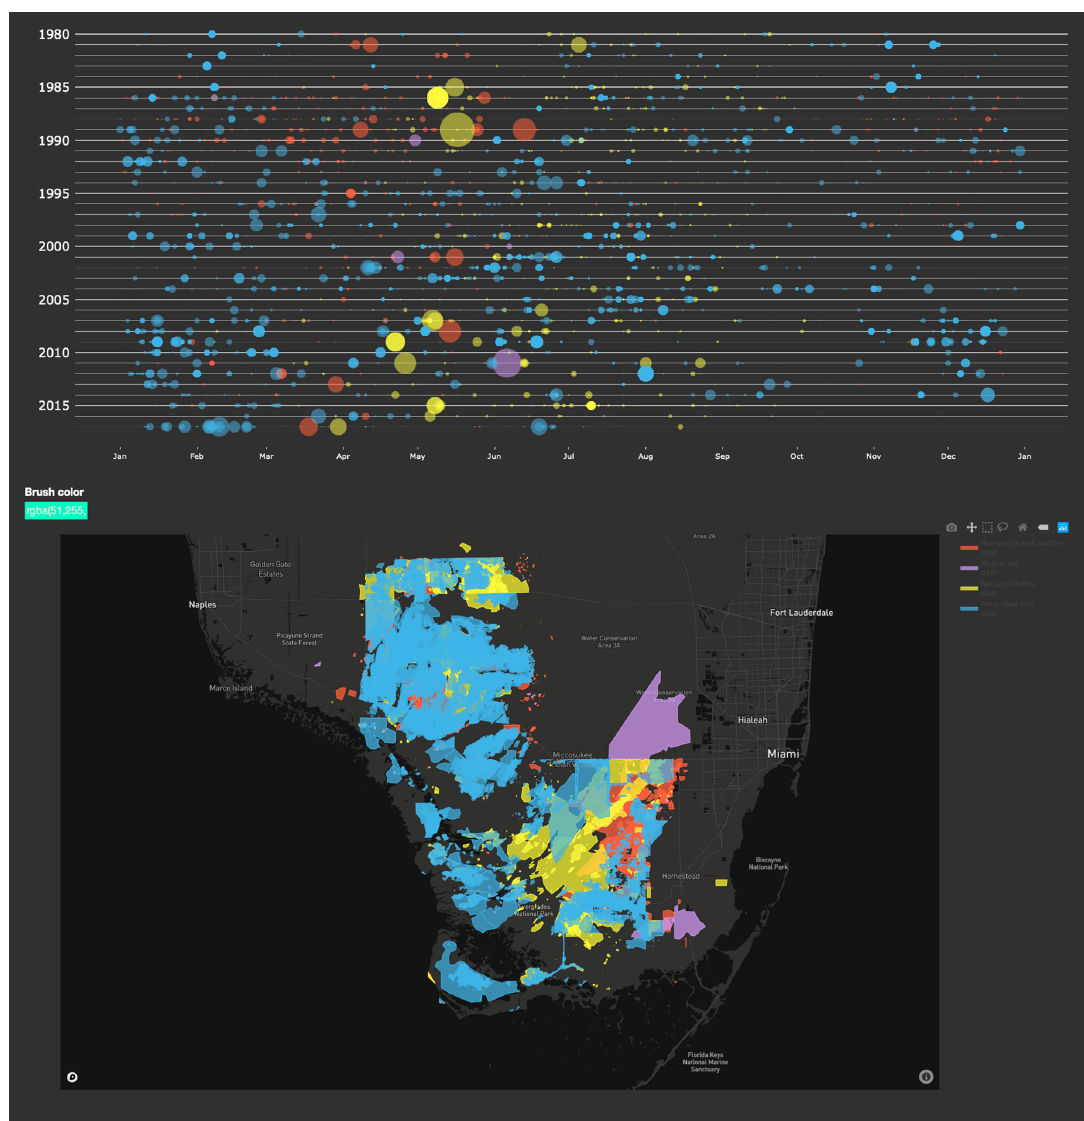
Figure 4. Everglades National Park and Big Cypress National Preserve fire history data, 1980-2017, depicting natural (yellow), human-caused (red), prescribed (blue), and mutual aid (purple) fires. The size of each point on the chart (top) corresponds to the fire’s size. An interactive map (bottom) displays corresponding fire perimeters.